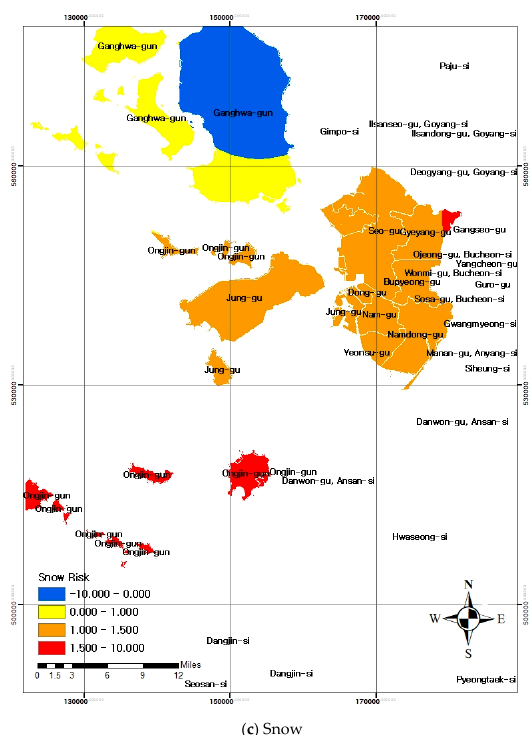
Figure 6. Risk map. Figure 6. Risk map.